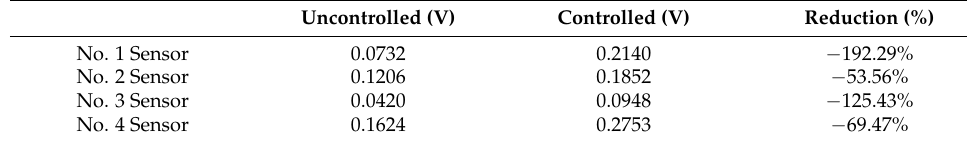
Table 9. RMS values of sensor signals.